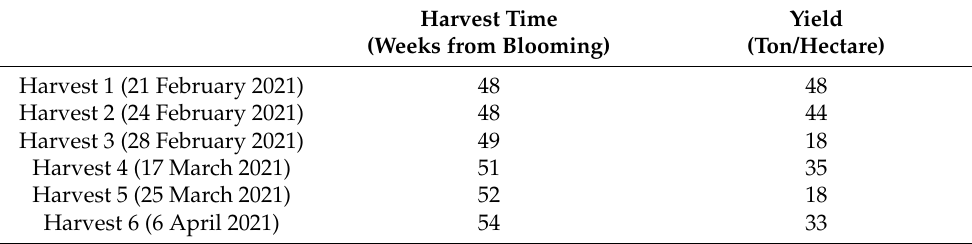
Table 1. Harvest times and yields for the six different orchards used for the current experiment.